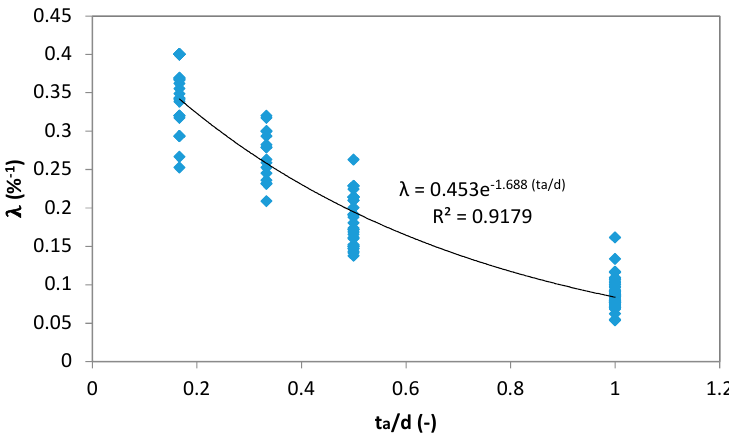
Figure 7. Behavior of the λ parameter as a function of the ratio between temporal aggregation, t a , and duration, d , for all selected rainfall stations and for t a / d ≥ 0.1666. The best interpolating function is also plotted.